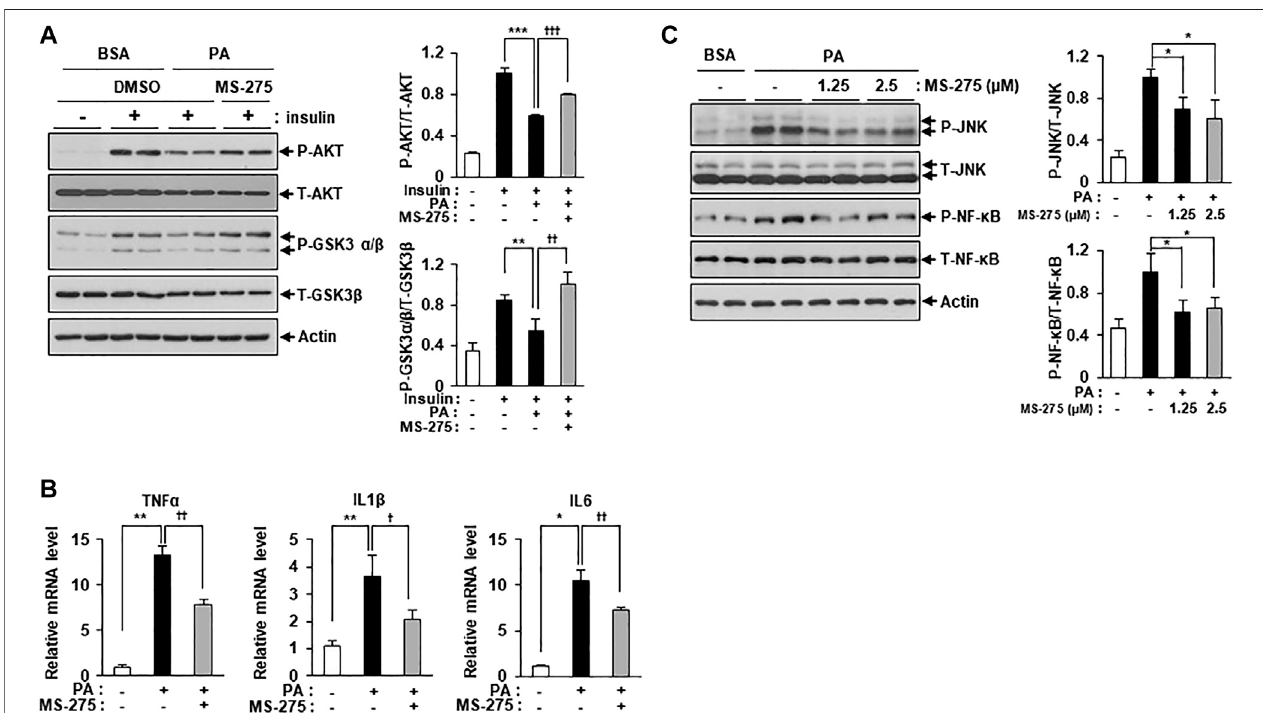
FIGURE 2 | MS-275 restored PA-induced insulin resistance and in fl ammation in C2C12 myotubes. (A) C2C12 myotubes were treated with 2.5 μ M MS-275 in the presence of 300 μ M PA for 12 h, and then stimulated with 100 nM insulin for 20 min. Cells were then harvested and analyzed by Western blot. The levels of insulin signaling-related proteins (p-AKT and p-GSK3 β ) were detected by Western blot; ** p < 0.01; *** p < 0.001 vs. insulin-stimulated and PA-untreated cells, †† p < 0.01; ††† p < 0.001 vs. insulin-stimulated and PA-treated cells. (B) After treatment with 300 μ M PA with or without 2.5 μ M MS-275 for 12 h, the expression of in fl ammatory genes(TNF- α , IL-1 β ,and IL-6) wasquanti fi ed byreal-time PCR.* p < 0.05; ** p < 0.01 vs. PA-untreated cells, † p < 0.05; †† p < 0.01 vs. PA-treated cells. (C) C2C12 myotubes were treated with the indicated dosage of MS-275 in the presence of 300 μ M PA for 12 h. The levels of stress/in fl ammation-related proteins were